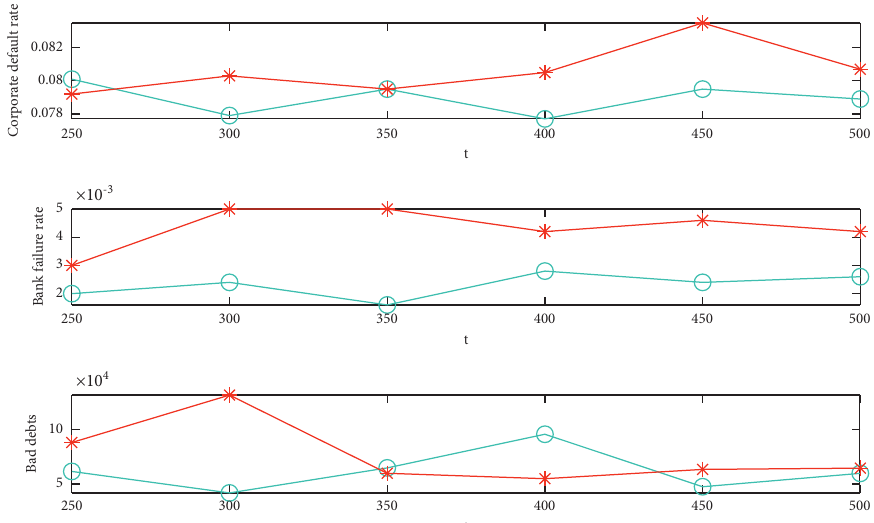
Figure 10: Evolution of risk contagion between the largest banks in terms of entry shocks and banking